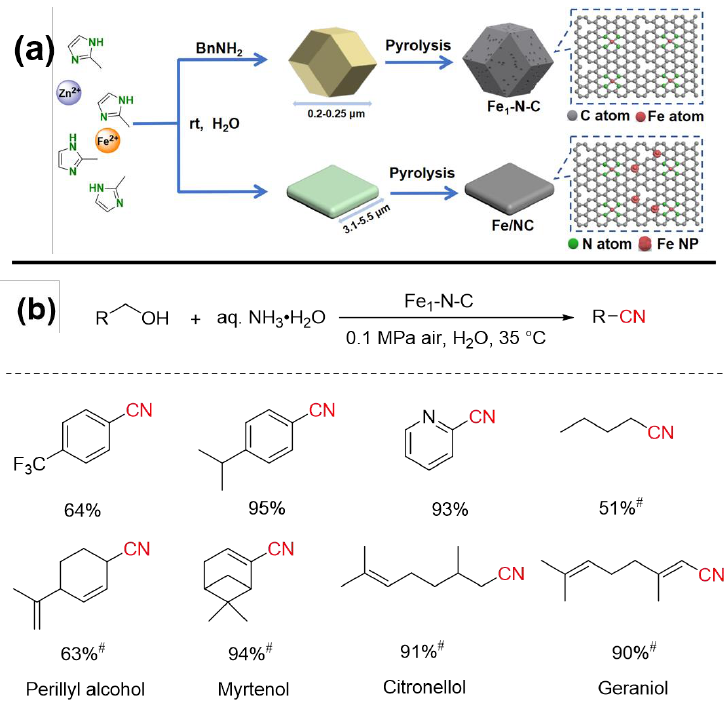
Figure 15. ( a ) Synthesis of Fe 1 -N-C catalyst (The illustration presented the possible structure of the catalyst). ( b ) Fe 1 -N-C catalyzed ammoxidation of alcohols to form nitriles. # 2 MPa air, 130 °C. Reprinted with permission from Ref. [91]. Copyright 2022, Springer Nature.